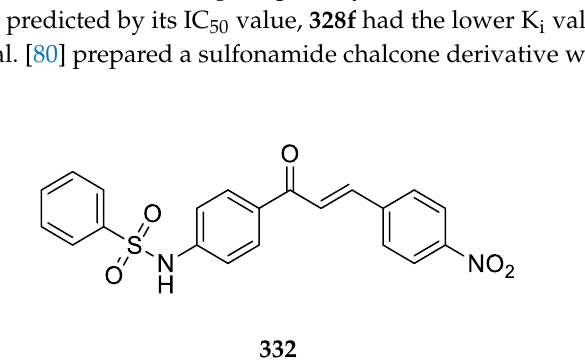
Figure 83. Chemical structure of a sulfonamide-4-aminochalcone derivative with substitution on ring B.